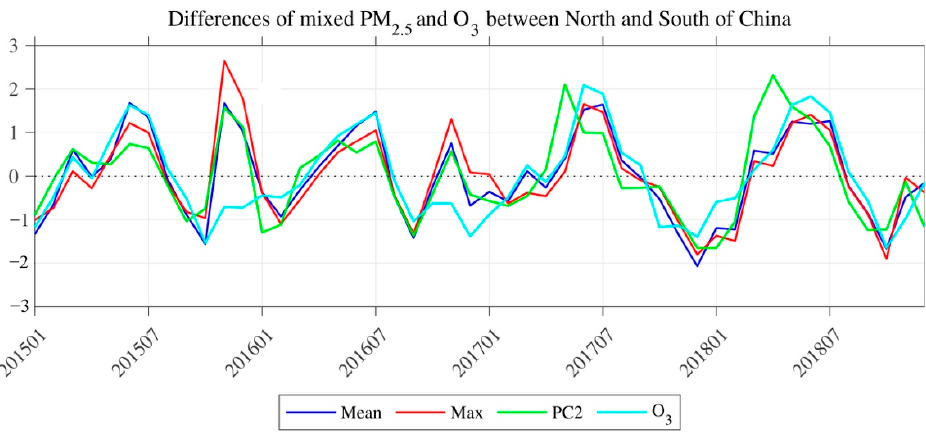
Figure 6. Normalized time series of AQI PC2 (green line), average differences of O 3 IAQI (cyan line), ensemble mean of PM 2.5 and O 3 IAQI (blue line), and maximum of the PM 2.5 and O 3 IAQI (red line) between the south and north of Eastern China from 2015 to 2018.